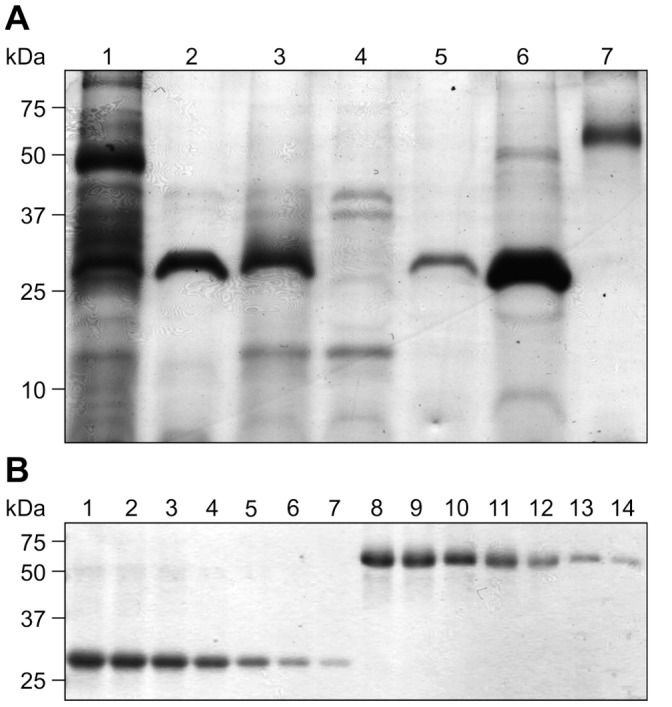
Purification of rFaeGntd/dsc from crude plant extract and quantification.(a) rFaeGntd/dsc was extracted from 5 g of mature transplastomic leaf tissue and purified. The initial volume of the extract was 50 ml; 3 µl of the extract from each step of the procedure were resolved by SDS-PAGE and stained. Lane 1 - Initial extract from leaf tissue, pH = 7.5; lane 2 - extract acidified to pH = 2 and centrifuged; lane 3 - clarified extract neutralized to pH = 7.4; Lane 4 - flowthrough from IMAC column; Lane 5 - wash with 20 mM imidazole; Lane 6 - elution of purified rFaeGntd/dsc; Lane 7 - 0.5 µg of BSA as loading control; kDa - protein molecular weight marker. (b) Purified rFaeGntd/dsc was quantified using densitometry. Dilutions of the purified rFaeGntd/dsc protein (lanes 1 through 7) were resolved in SDS-PAGE gel along with known amounts of BSA (lanes 8–14; 1.0, 0.8, 0.6, 0.4, 0.2, 0.1, 0.05 µg BSA, respectively) and stained. BSA bands were used for generation of a standard curve (R2 = 0.987; p = 0.01) and extrapolating rFaeGntd/dsc concentration. kDa - molecular weight marker.